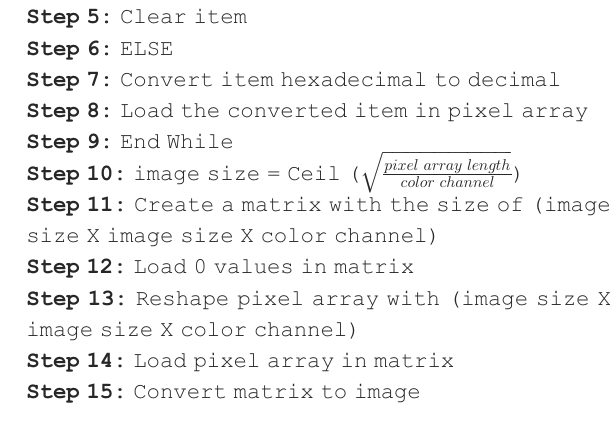
Algorithm 1. Firstly, the algorithm detects and removes meaningless line numbers, characters, and numbers such as “ ?? ”